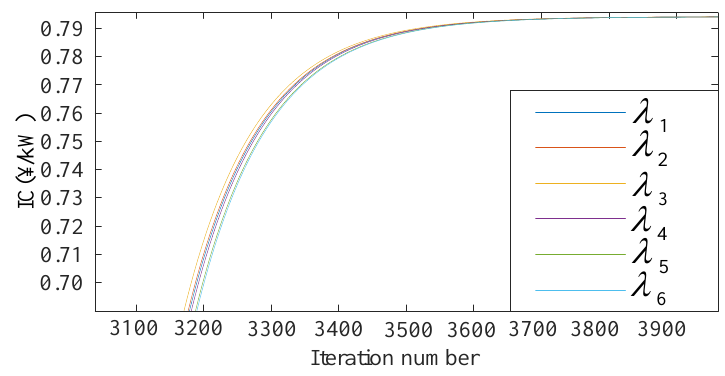
Figure 13. The power of each customer with chain connection.